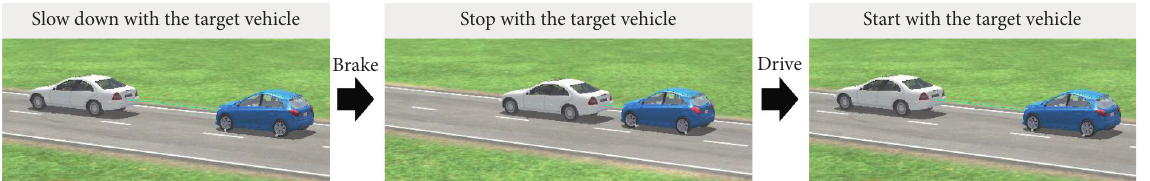
Figure 11: The vehicle autonomous stop-and-go task in CARSIM.